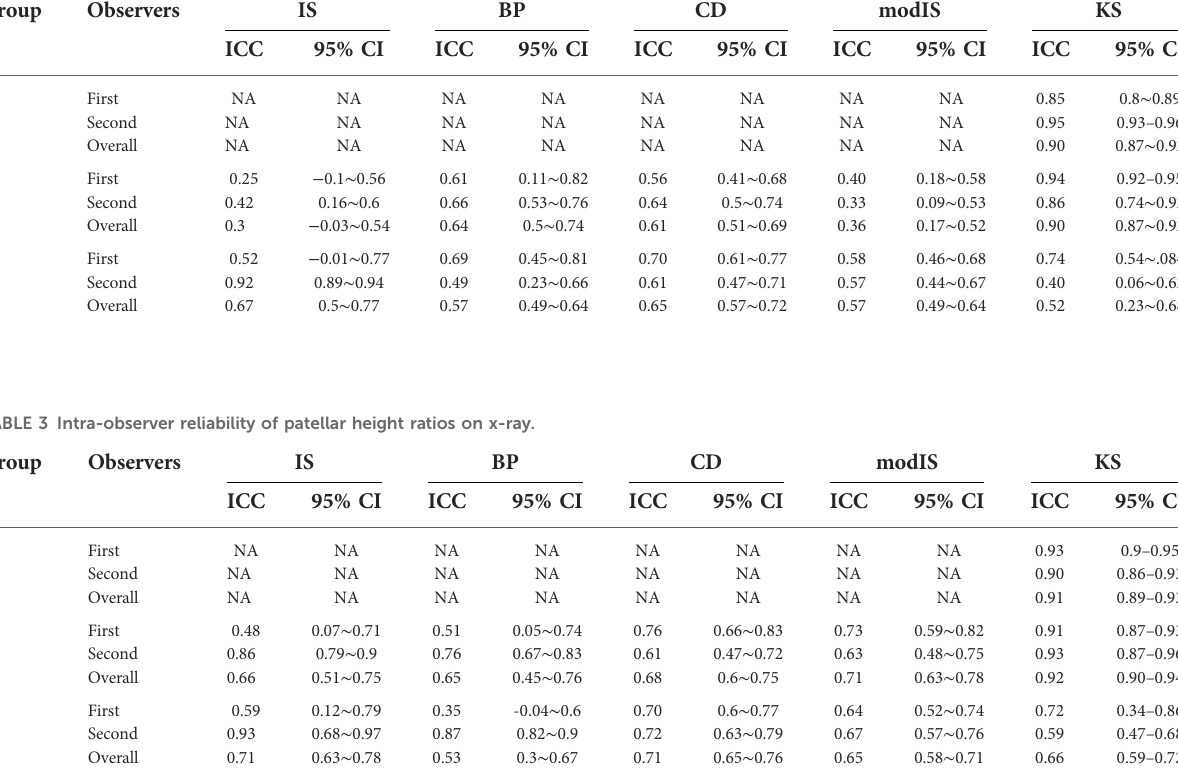
TABLE 2 Inter-observer variability of patellar height ratios on x-ray. Group